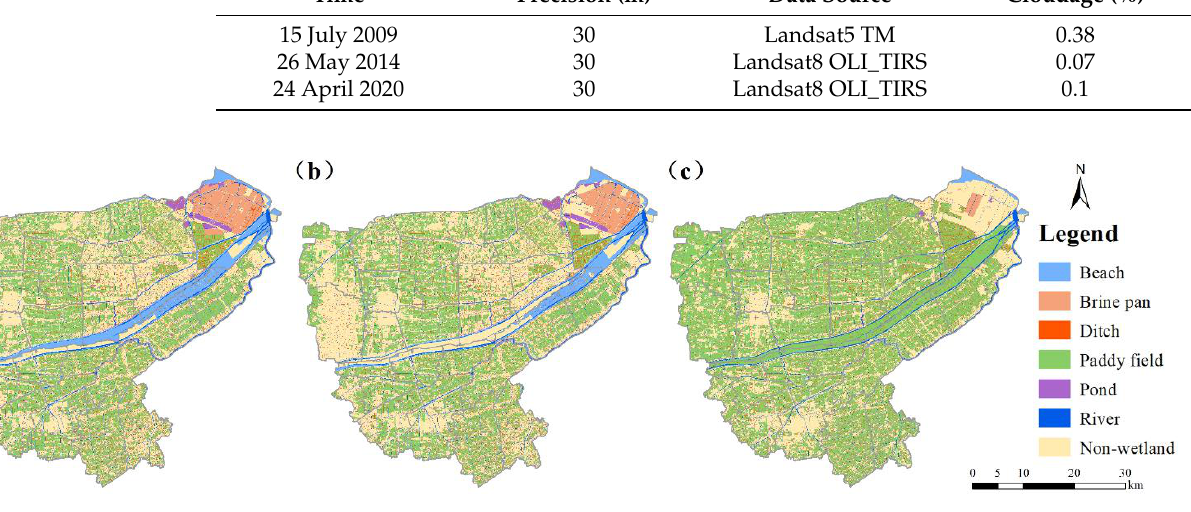
Figure 2. The present situation of LULC in different years: ( a ) 2009; ( b ) 2014; ( c ) 2020. Based on the image data and land use status data, the boundaries of the city, village, port, industrial land, and coastline were extracted by ArcGIS 10.3. According to the present situation of LULC, the urban agglomeration areas were extracted as the city center, and the relevant distance data were obtained by calculating the distance between the patches of each wetland type and the geometric center of the city center, port, coastline, and industrial land.